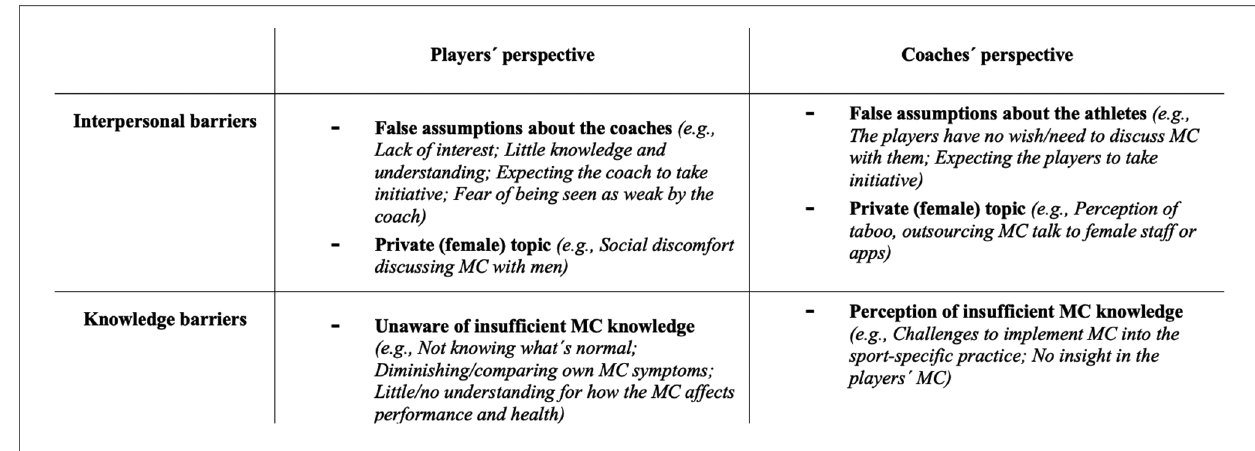
FIGURE 1 Description of the barriers experienced by the players and coaches based on the thematic